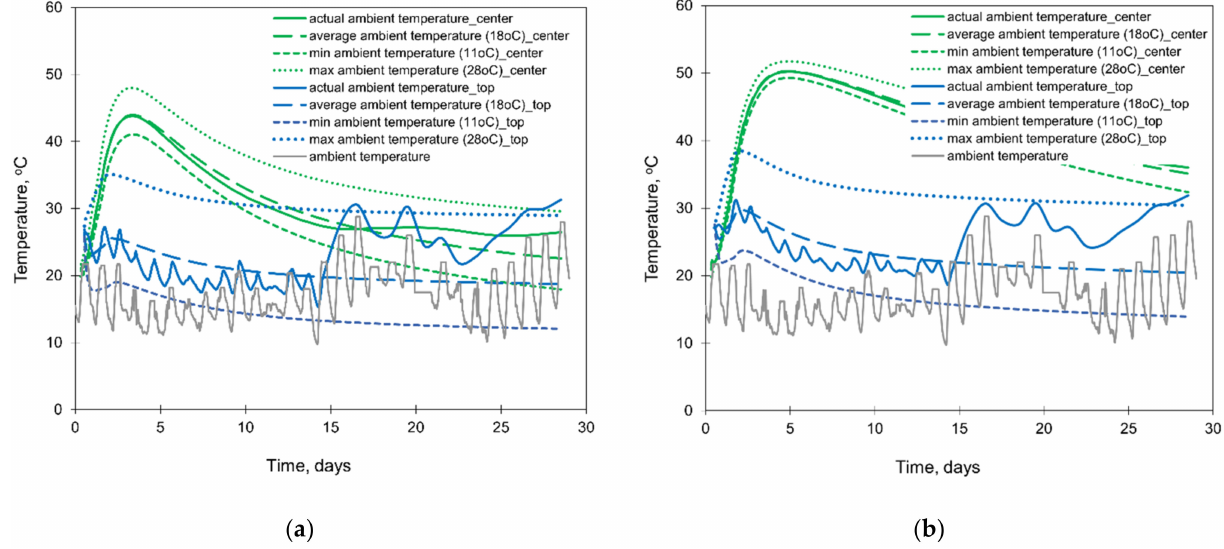
Figure 18. The effect of the ambient temperature on the temperature developments in the slabs with thicknesses of ( a ) 2 m and ( b ) 4